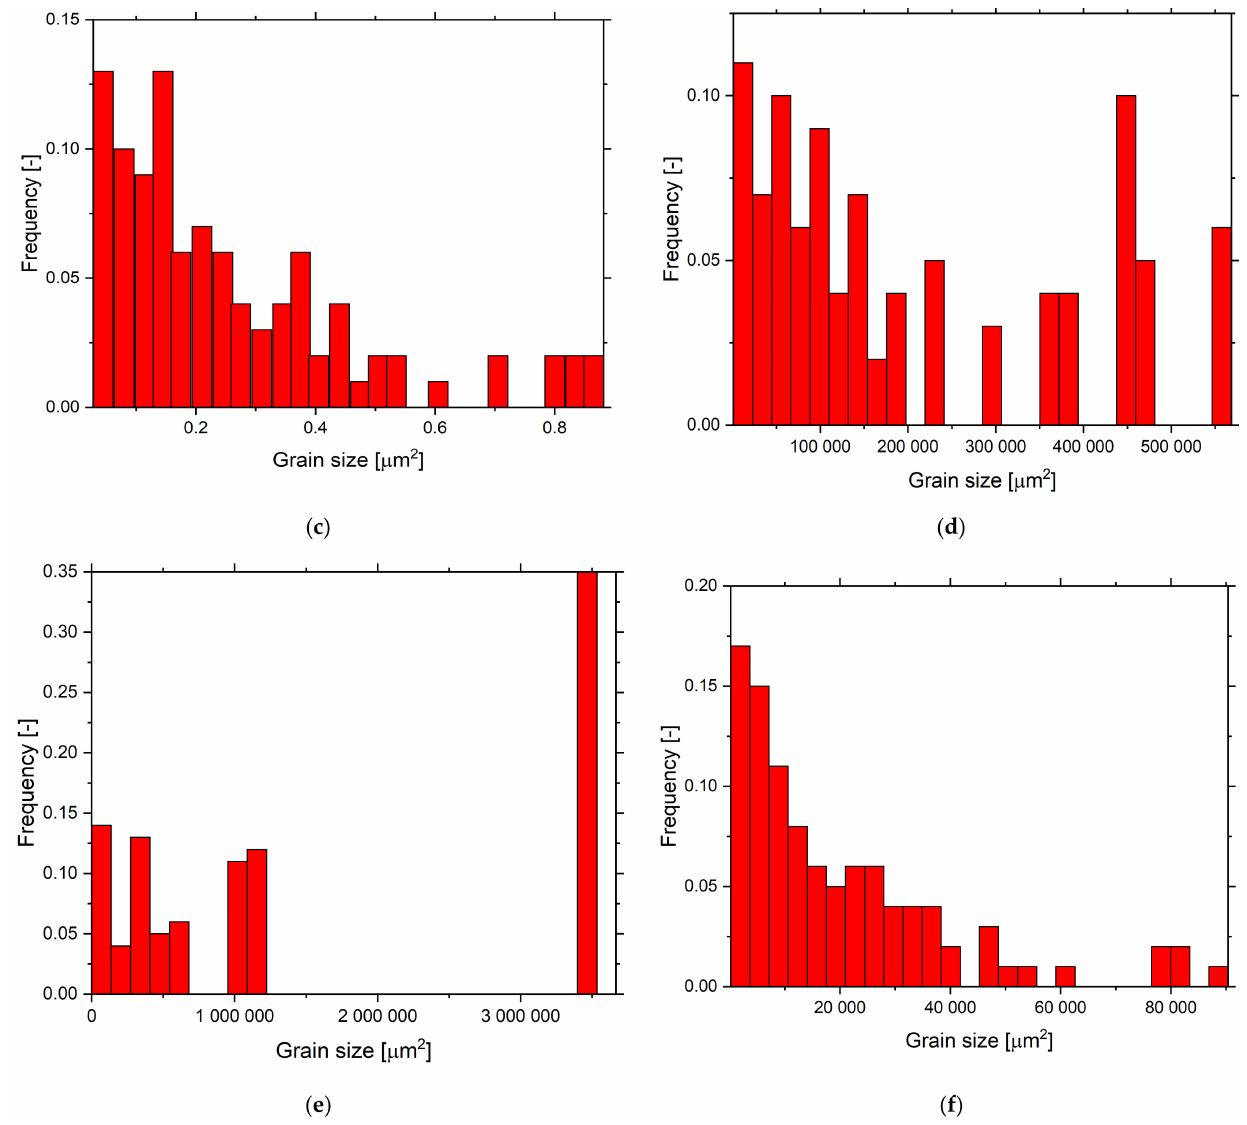
Figure 4. Histograms of grain areas for Fe-10Al-4Y 2 O 3 ODS alloys and aspect ratios (numbers in brackets) with ( a ) 0% Y (2.7), ( b ) 1% Y (5.7), and ( c ) 1.75% Y (1.7) and for Fe-10Al-4Cr-4Y 2 O 3 ODS alloys with ( d ) 0% Y (3.6), ( e ) 1.25% Y (6.7), and ( f ) 1.75% Y